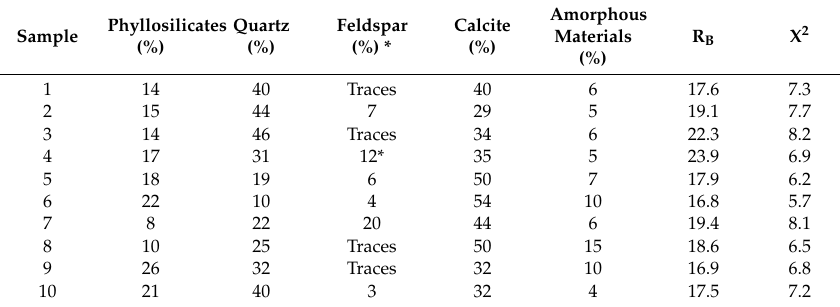
Table 2. Mineralogical composition (%) of total sample from B horizons by XRD. Sample